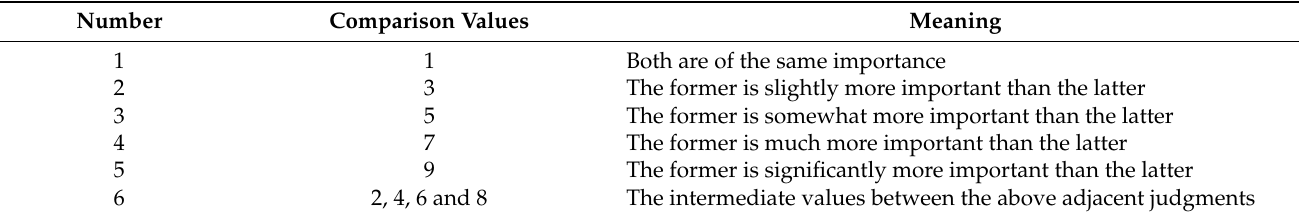
Table 4. The standard group